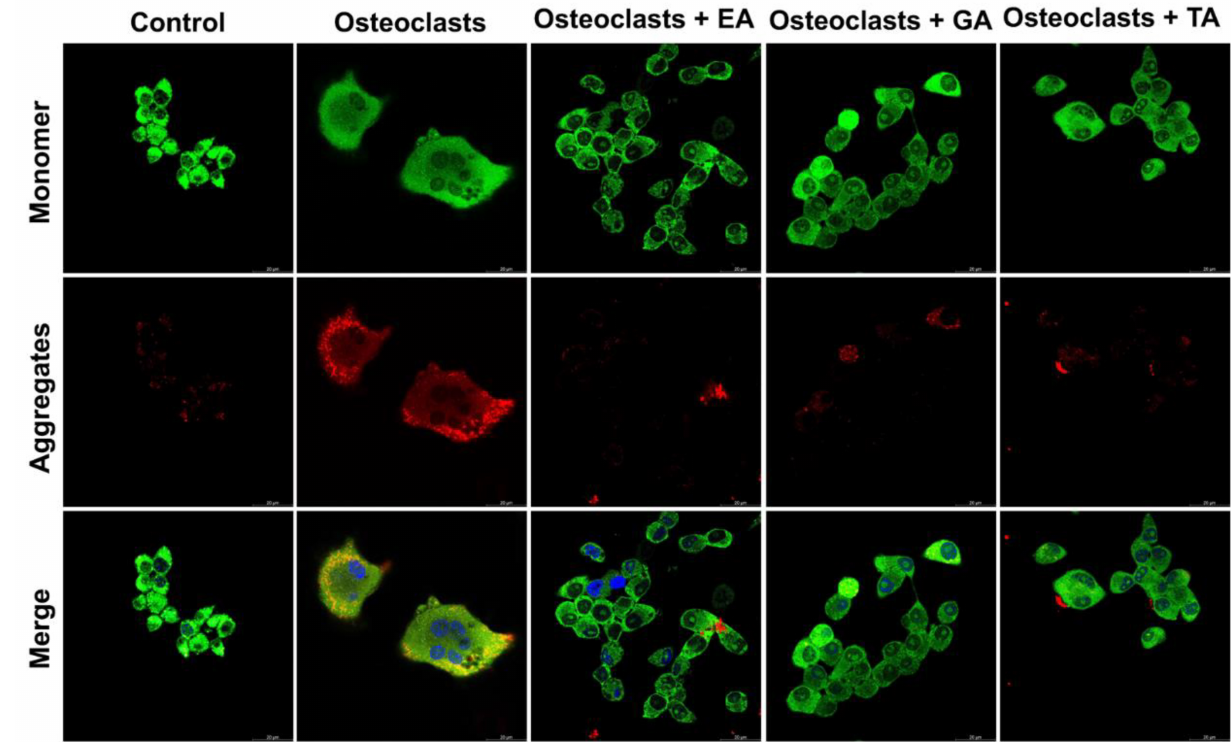
Figure 8. Polyphenolic compounds reduce mitochondrial membrane potential in differentiated osteoclasts. Images of stained mitochondrial membrane potential in differentiated osteoclasts are presented in the absence or presence of ellagic acid (EA), gallic acid (GA), and tannic acid (TA) keeping undifferentiated cells as a control. Green color indicates the monomeric form of the stained JC-1 dye, and red color indicates an aggregate form of the stained JC-1